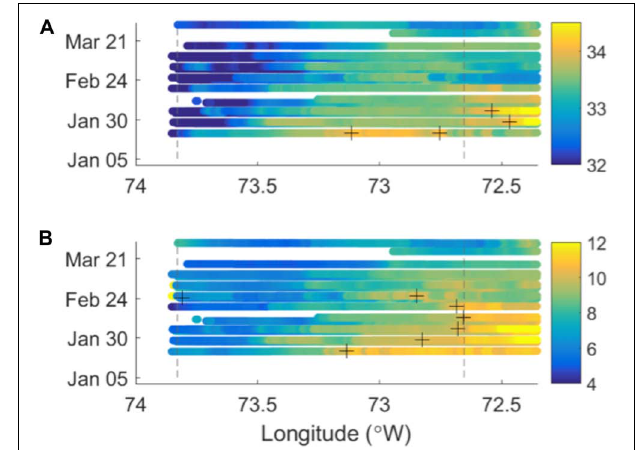
FIGURE 7 | Time series of (A) cross-shelf salinity and (B) temperature (lower panel) from the CMV Oleander thermo-salinograph from mid-January 2017 through late March 2017. The dotted line on the left is near the Ambrose Light off New Jersey at the 30 m isobath and the shelfbreak is at the dotted line on the right. The crosses indicate the most shoreward position of the 34.0 isohaline and 10 ◦ C isotherm. The units are Practical Salinity Units for salinity and Degrees Centigrade for